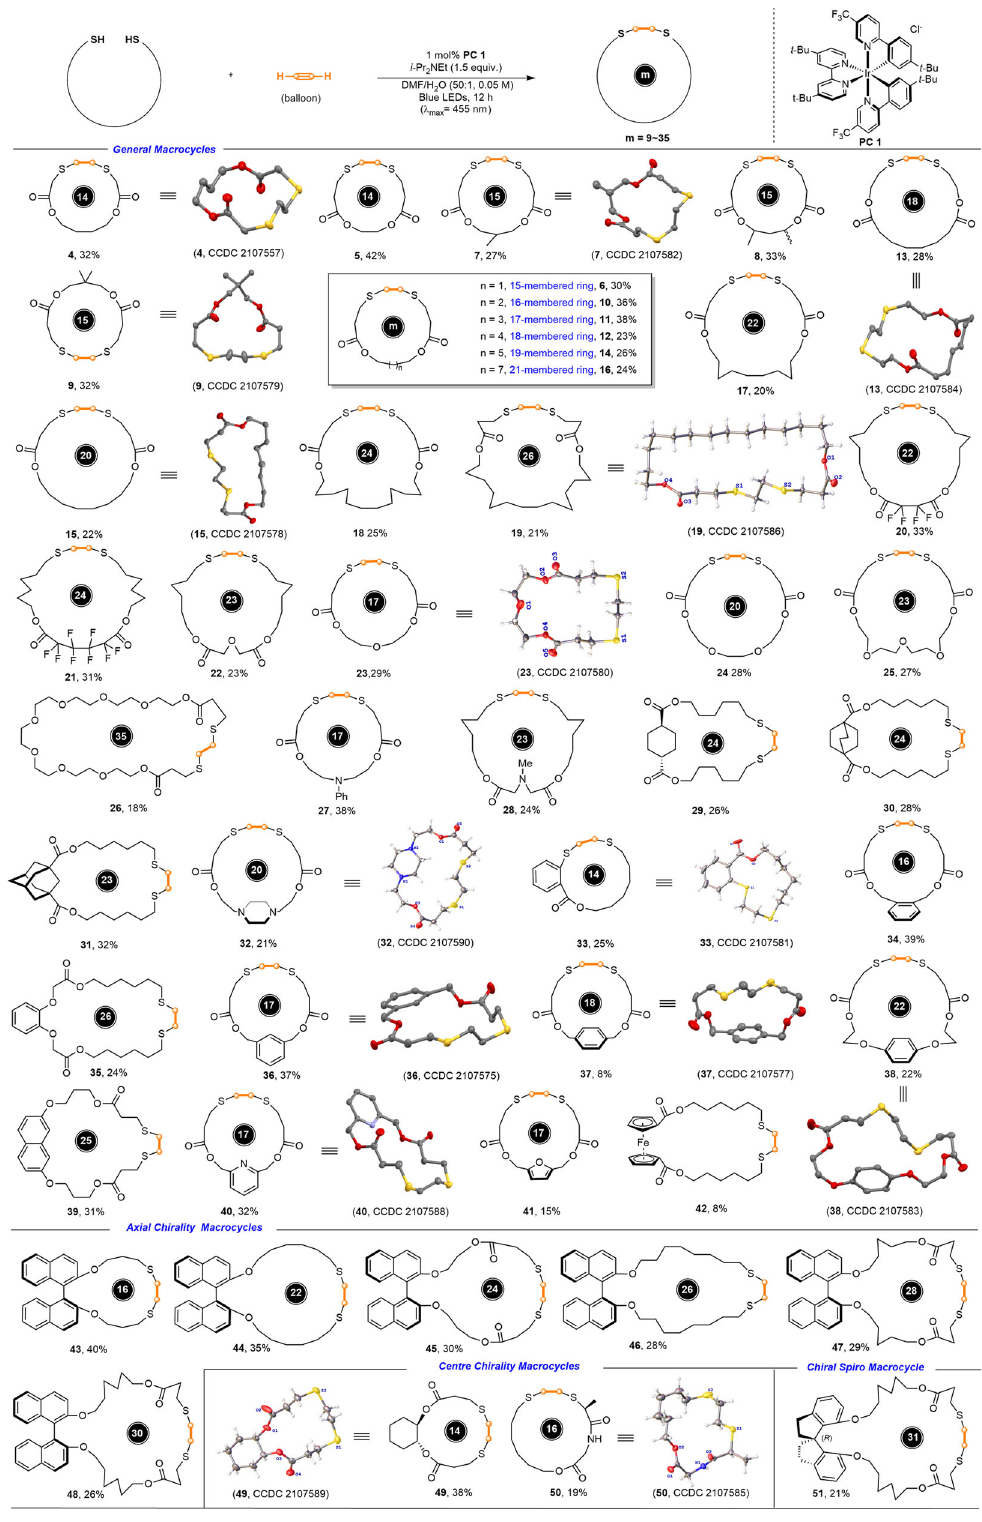
Fig. 2 | Substrate scope for synthesis of [1+1] patter-based macrocycles. Reaction conditions: DMF ( N,N -dimethylformamide), H 2 O (50:1, 0.05M), disul fi de